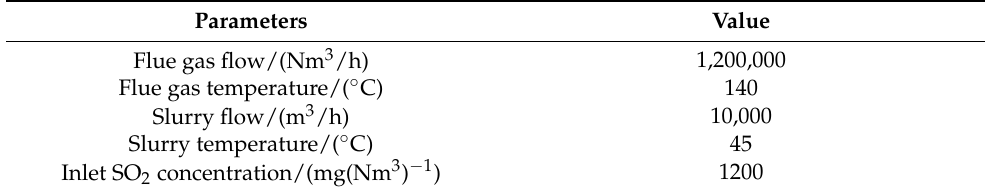
Figure 5. Tower internal structural parts: ( a ) Mist eliminator; ( b ) Spray levels; ( c ) Nozzles. Table 3. Operation parameters.